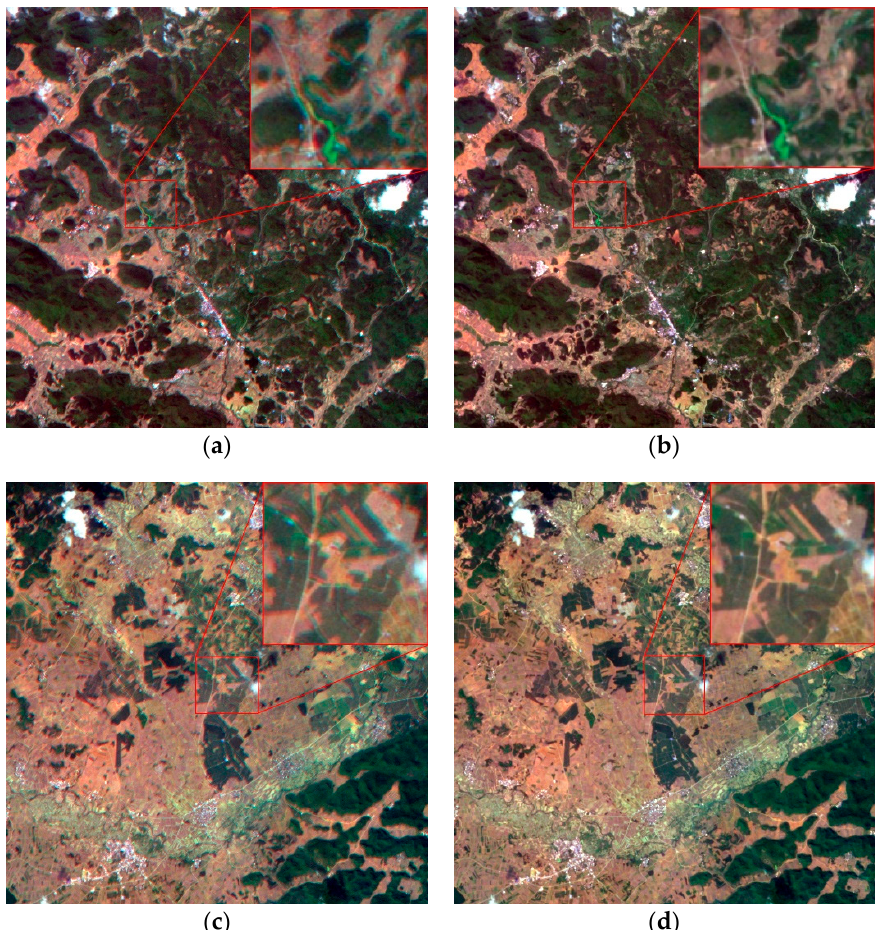
Figure 11. Comparison of registration results using IOEM and the proposed method. ( a ) IOEM method; ( b ) Proposed method; ( c ) IOEM method; ( d ) Proposed method.